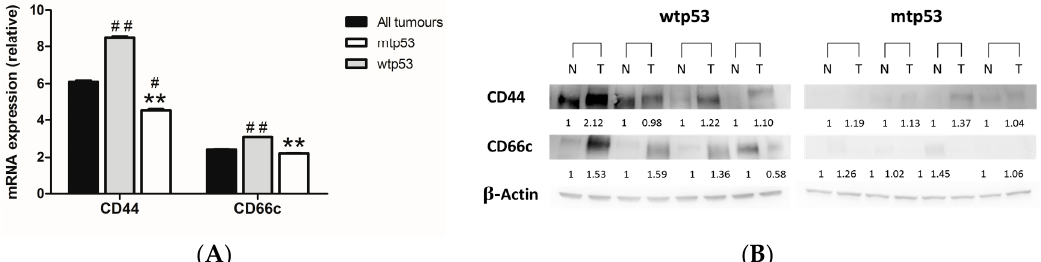
Figure 3. ( A ) mRNA relative expression of CD44 and CD66c in all patients, patients with wtp53 tumors and patients with mtp53 tumors. Data represent mean ± S.E.M. ** p < 0.01 versus wild-type; # p < 0.05 versus all patients; ## p < 0.01 versus all patients; ( B ) Protein expression of CD44 and CD66c in normal (N) and malignant (T) colon samples in four patients with wtp53 and four patients with mtp53 tumors.